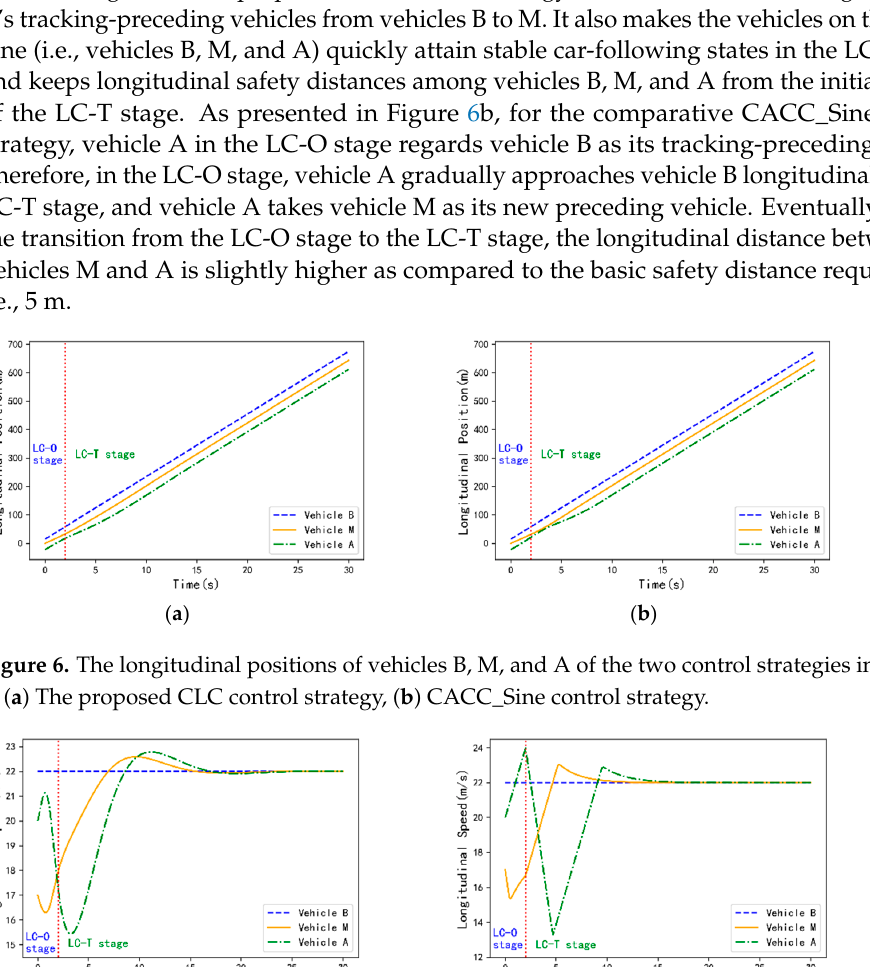
Figure 7. The longitudinal speeds of vehicles B, M and A of the two control strategies in scenario 1. ( a ) The proposed CLC control strategy, ( b ) CACC_Sine control strategy.